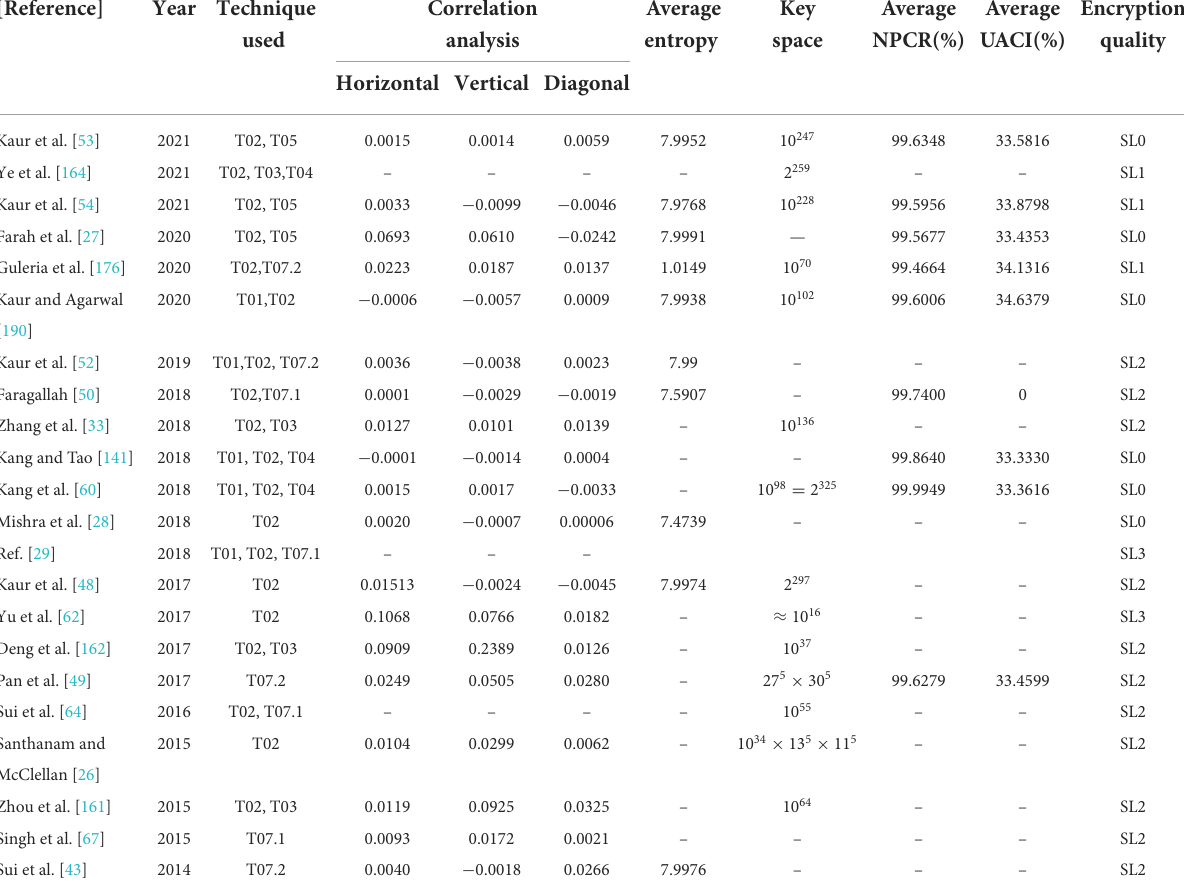
TABLE 8 Comparative analysis for performance metrics of proposed schemes (for Lena